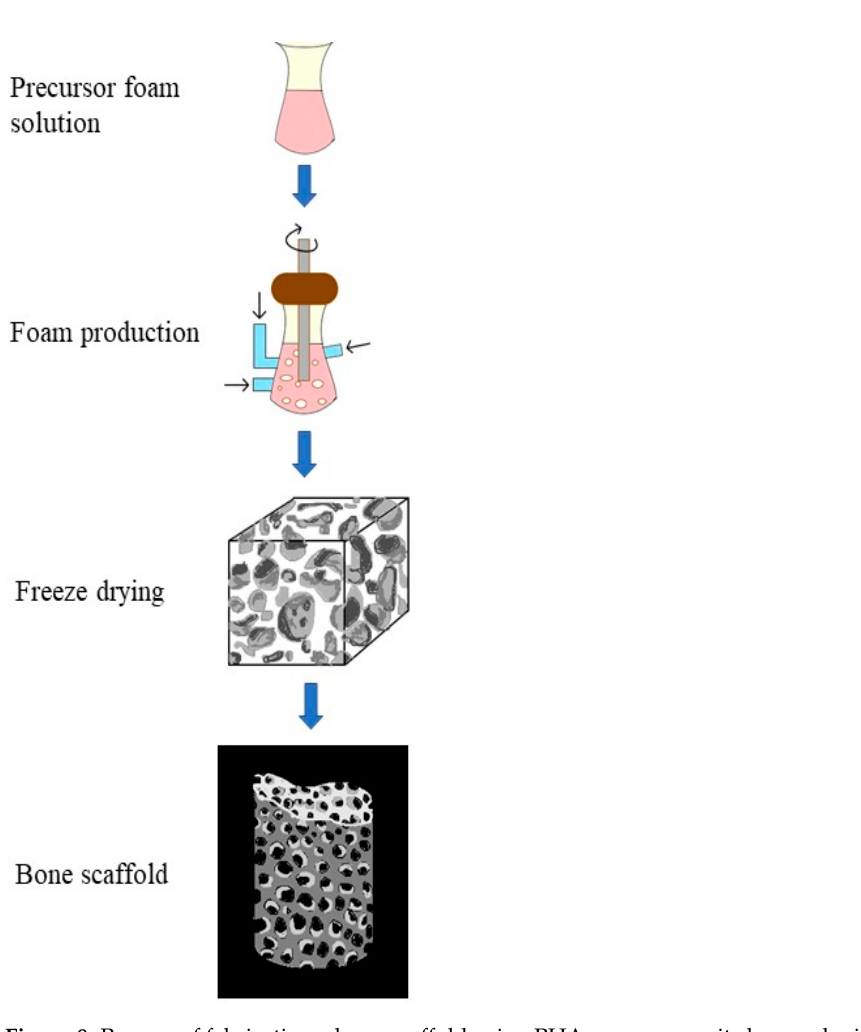
Figure 8. Process of fabricating a bone scaffold using PHA nanocomposite by employing gas foaming strategy.